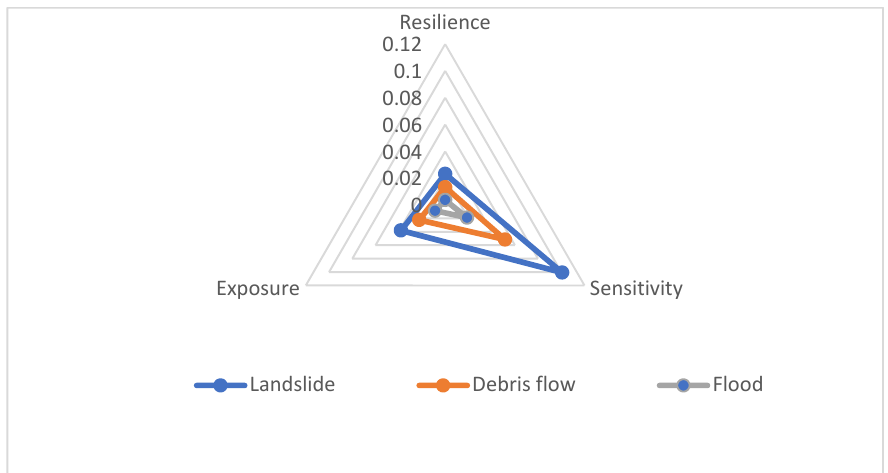
Figure 5. Spider diagram of the major components of IPCC-LVI for different livelihoods strategies.